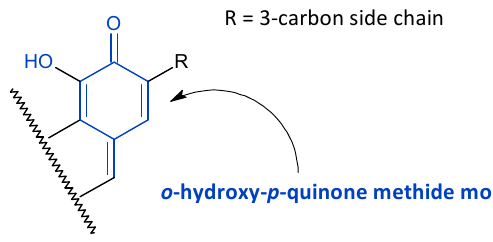
Figure 4. Quinone methide skeleton.